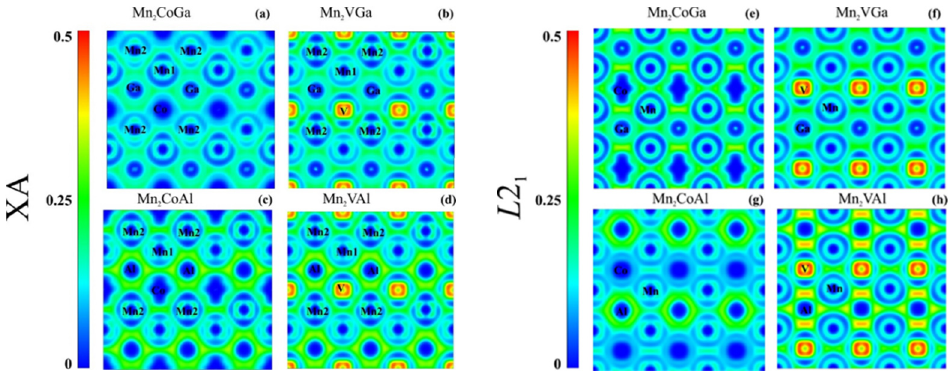
Figure 3. Calculated ELF in the (110) plane of ( a ) Mn 2 CoGa, ( b ) Mn 2 VGa, ( c ) Mn 2 CoAl, and ( d ) Mn 2 VAl of XA and ( e ) Mn 2 CoGa, ( f ) Mn 2 VGa, ( g ) Mn 2 CoAl, and ( h ) Mn 2 VAl of L 2 1 structures.